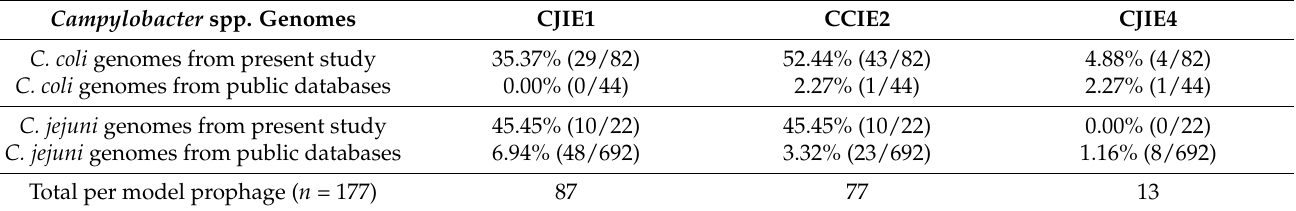
Table 3. Presence of C. coli - and C. jejuni -harbored prophages in the genomes analyzed. Campylobacter spp.